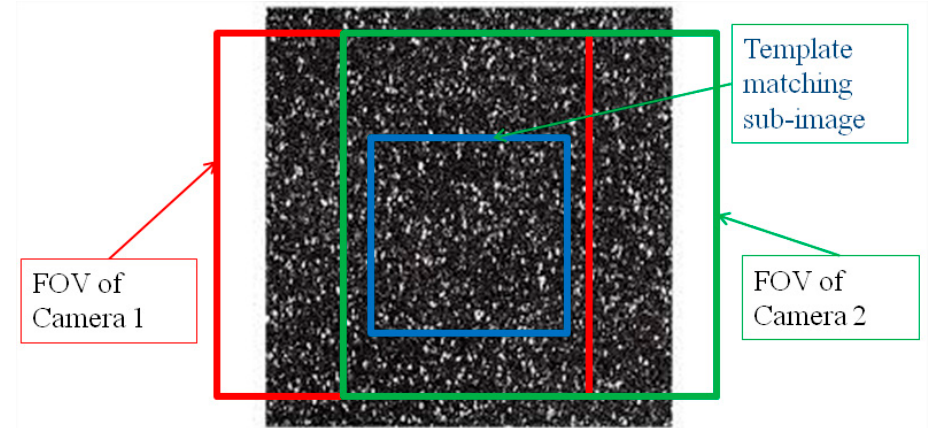
Figure 6. Proposed idea of dual camera mapping using random speckles.